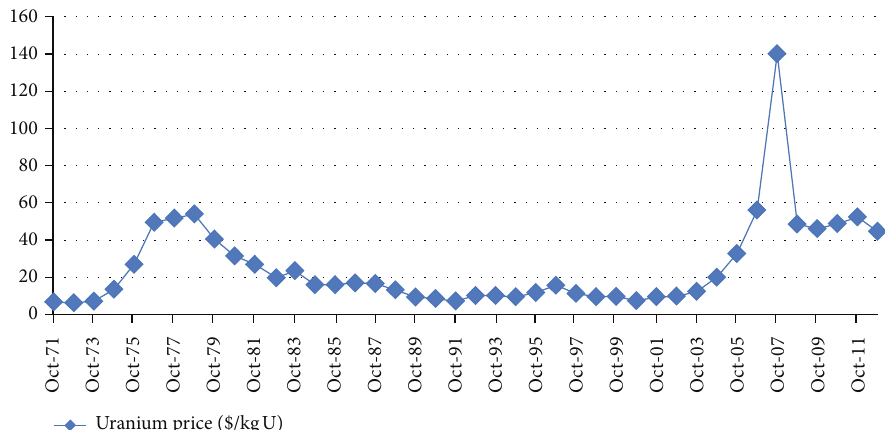
Figure 2: Uranium price chart.